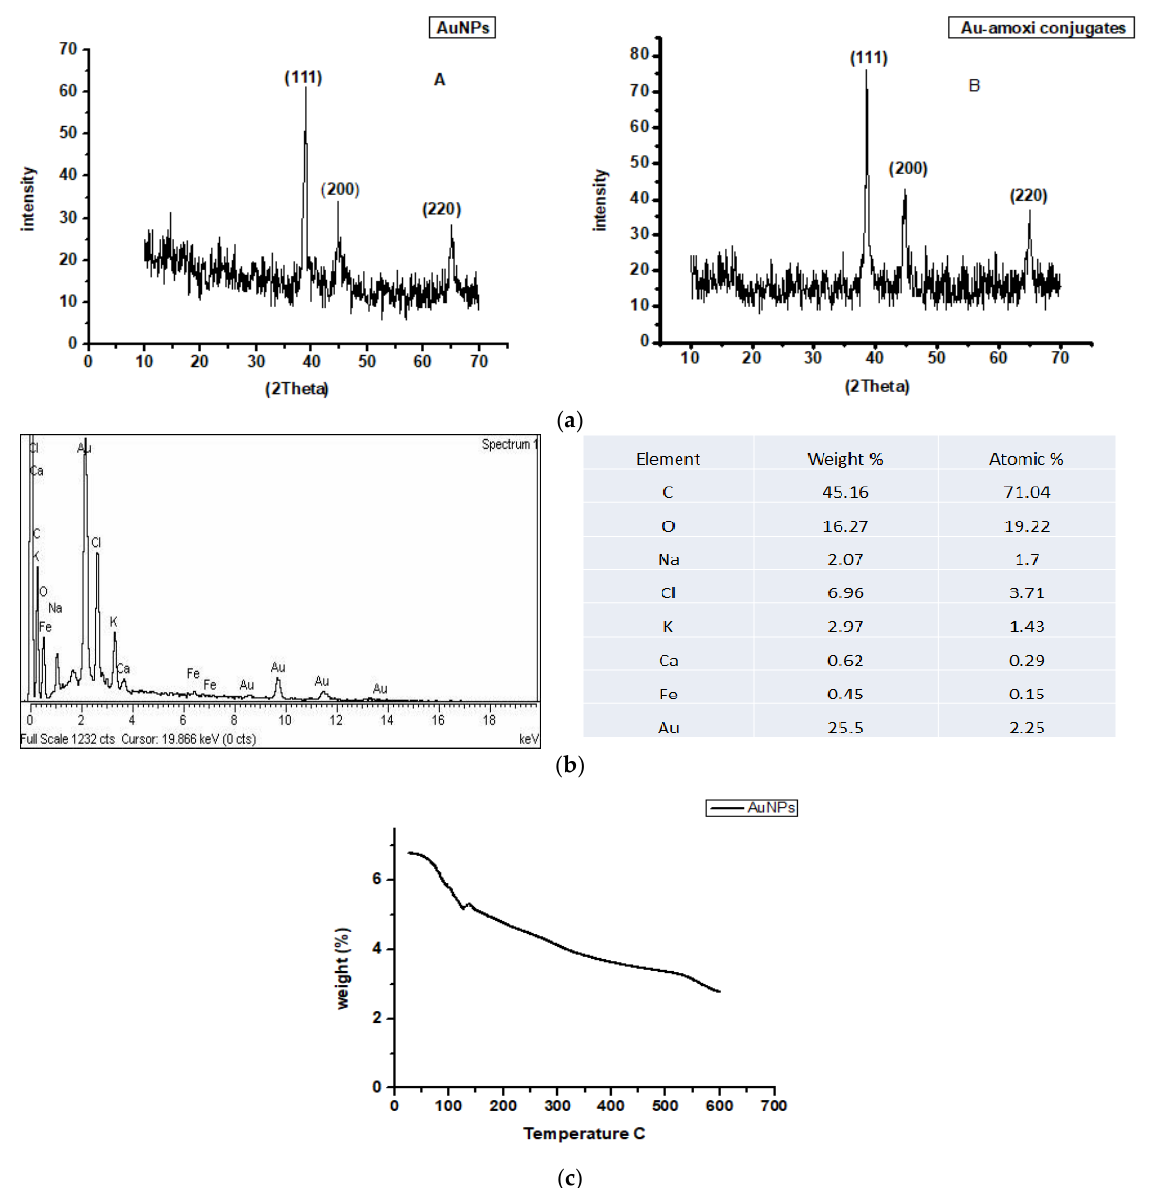
Figure 4. ( a ) XRD analysis of AuNPs (A) and Au-amoxi conjugate (B). ( b ) Elemental analysis (EDX) of AuNPs functionalized Micromeria biflora . ( c ) TGA analysis of AuNPs functionalized Micromeria biflora.